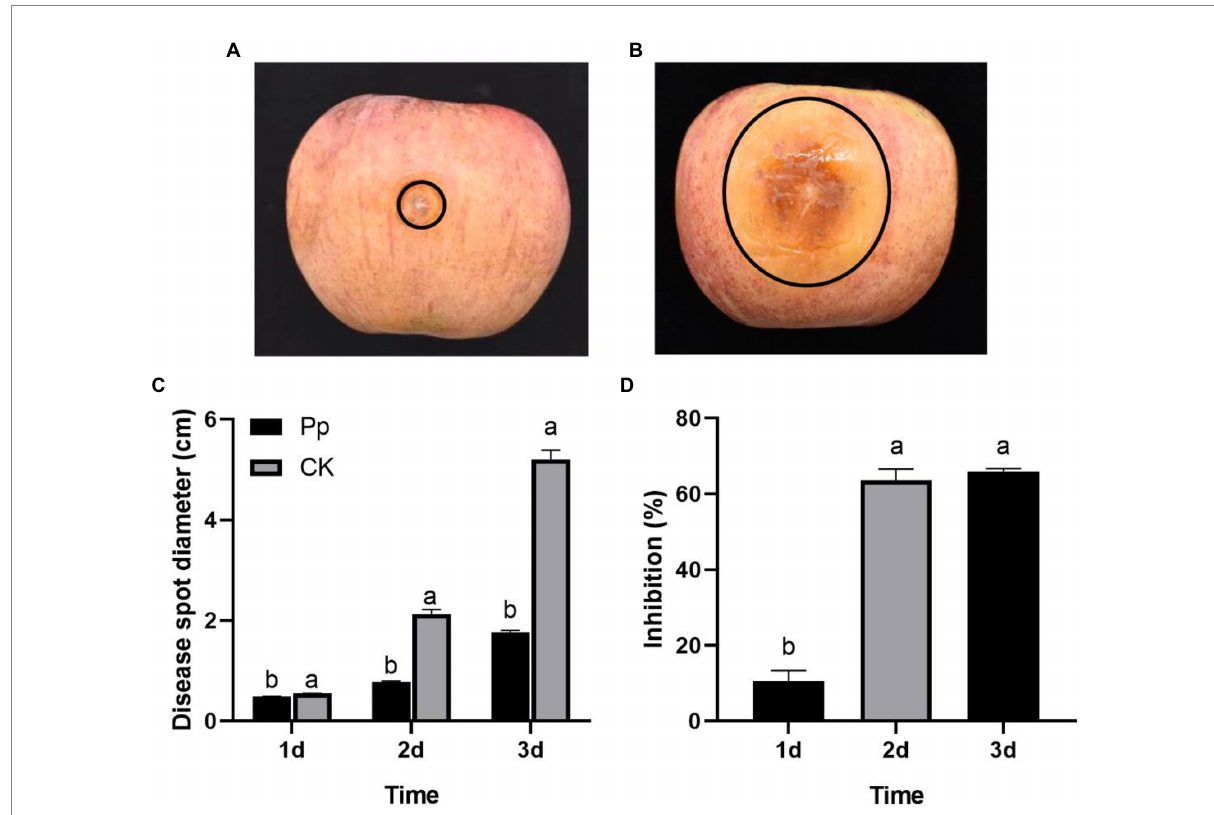
FIGURE 3 The inhibitory effect of P. protegens on apple ring rot on postharvest fruits (Experiment 1). The disease symptom on the P. protegens- treated fruits (A) and the untreated control fruits (B) 3 days later. The disease spot diameter of the P. protegens- treated fruits was significantly smaller than the untreated control (C) , demonstrating that P. protegens had potent inhibition on the ring rot disease on postharvest apple fruits (D) . Lowercase letters indicate a significant difference between treatments ( p <